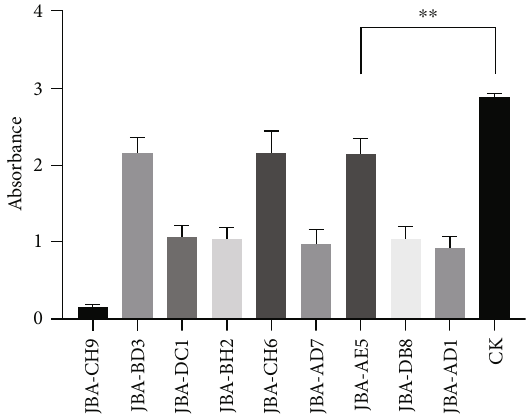
Figure 2: Evaluation of nitrite degradation ability of screened